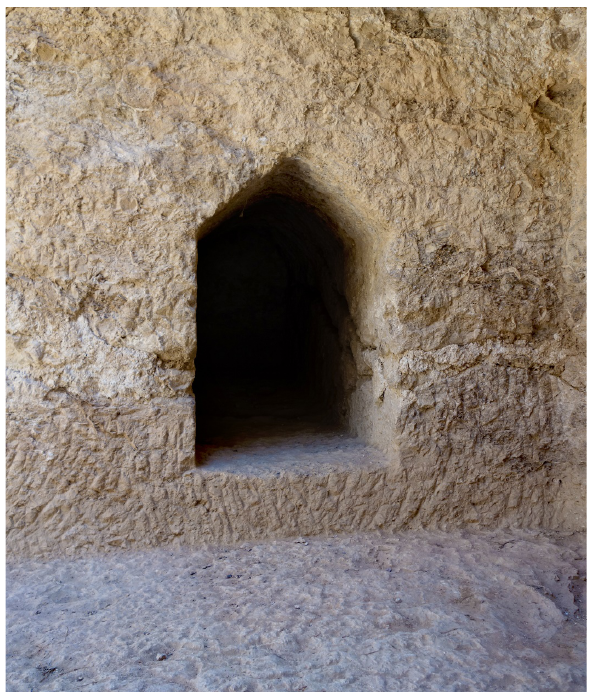
Figure 10. Loculi of the burial chamber.